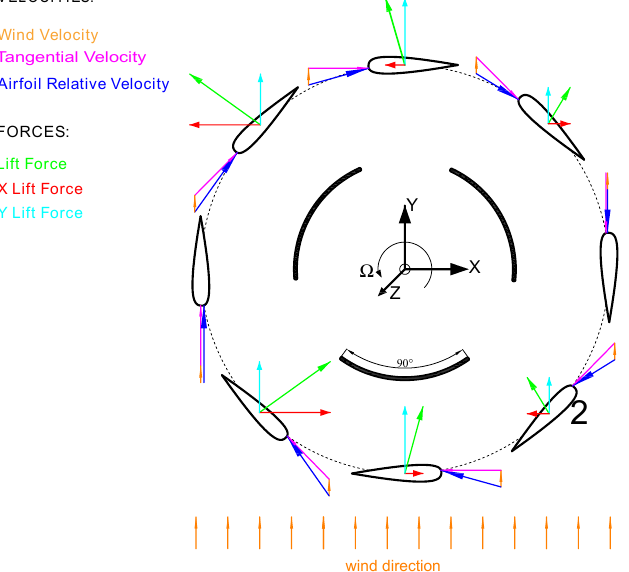
Figure 15. Forces component variability with respect angular